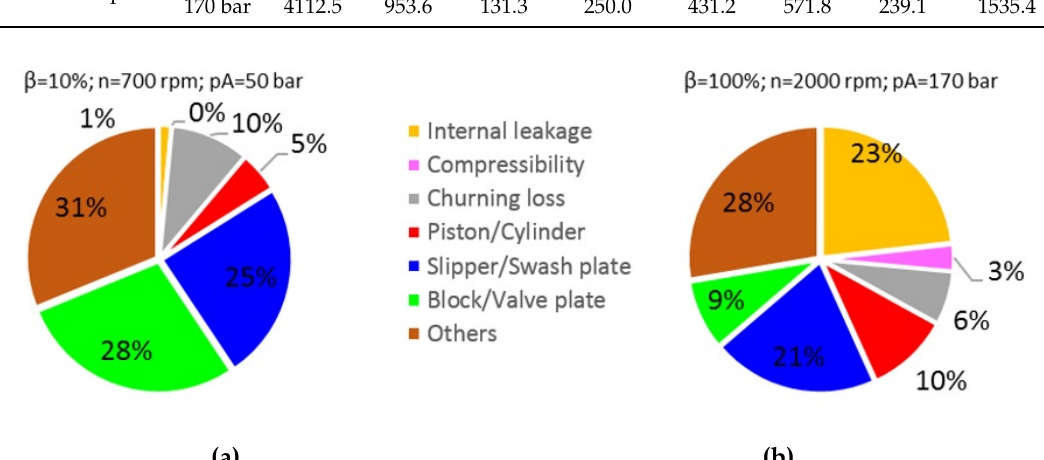
Figure 21. ( a ) Distribution of power losses at low power operating condition and θ B = 50 ◦ C; Figure 21. (a) Distribution of power losses at low power operating condition and θ B = 50 °C; (b) ( b ) distribution of power losses at high power operating condition and θ B = 50 ◦ distribution of power losses at high power operating condition and θ B = 50 °C. Table 6. Distribution of power losses in the S-APP a 52 cc size; θ B = 70 °C. Power losses (W)